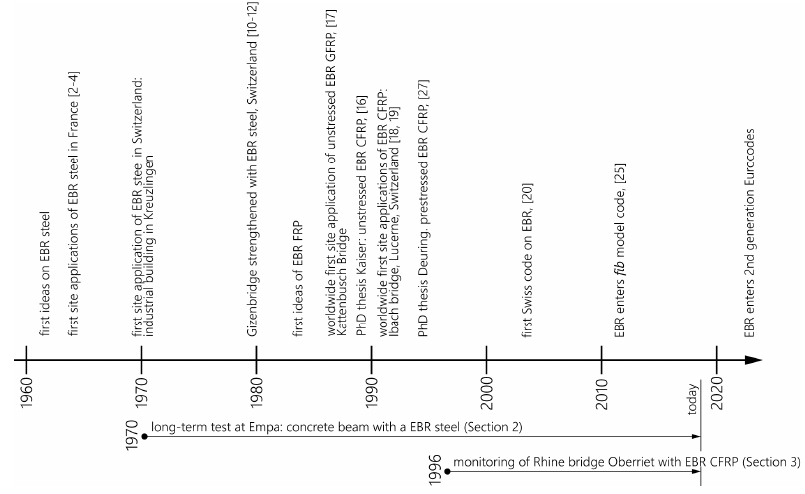
Figure 1. The idea of externally bonded reinforcement presented by Bresson [2] in the year 1967, taken from [2].